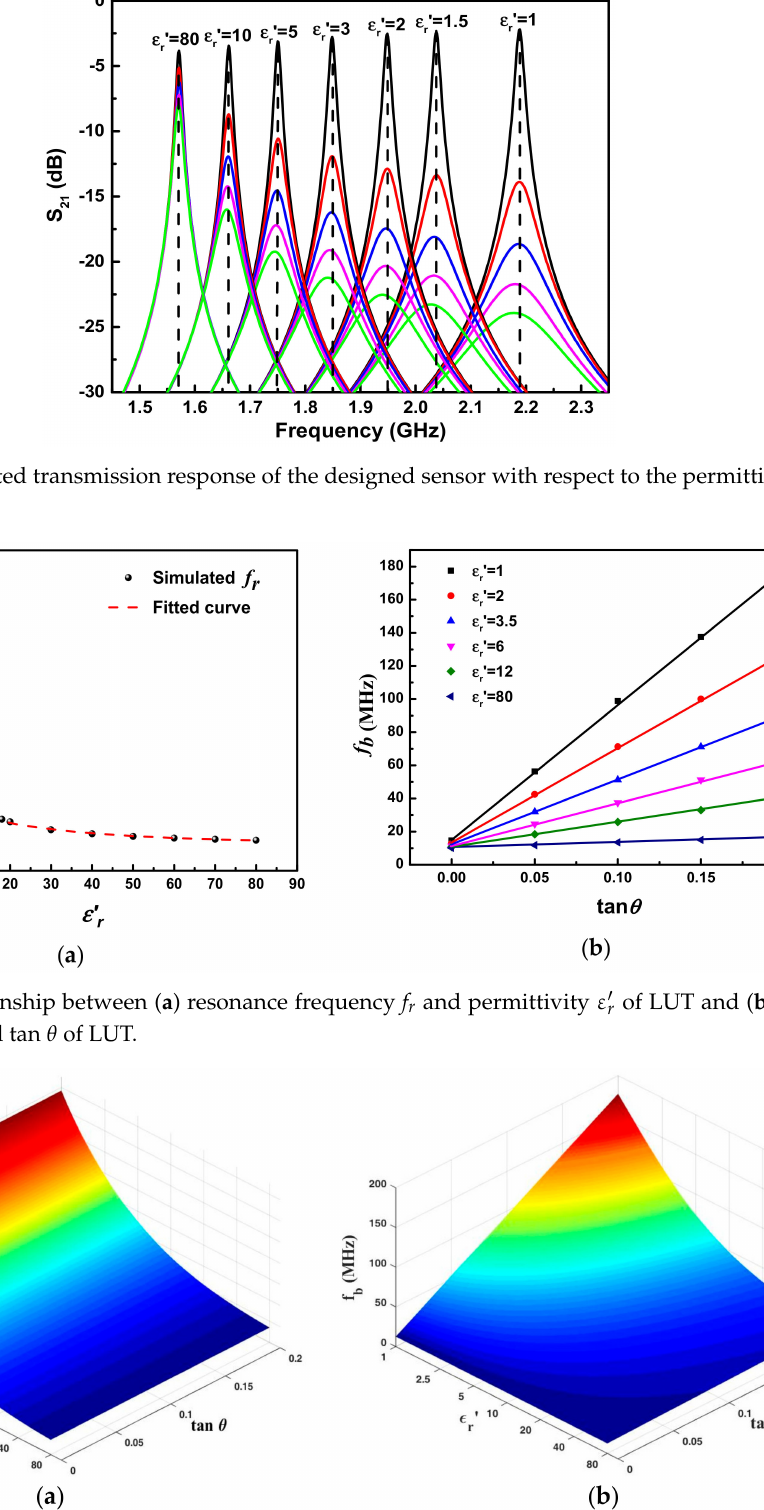
Figure 9. 3D plots of the simulated ( a ) resonance frequency and ( b ) 3-dB bandwidth as a function of permittivity ε (cid:48) r and tan θ